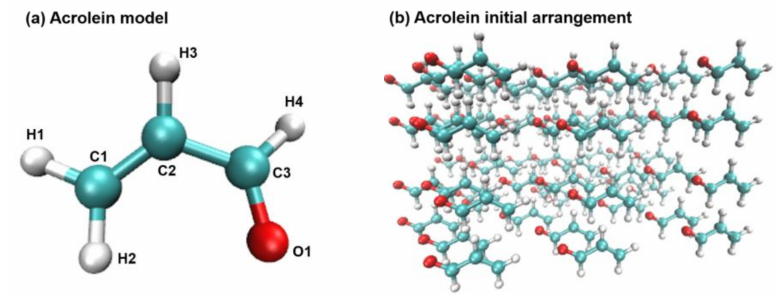
Figure 7. Acrolein model: ( a ) The ball-and-stick model of an acrolein molecule. Color scheme: Hydrogen in white, oxygen in red, carbon in green; ( b ) initial arrangement of 72 acrolein